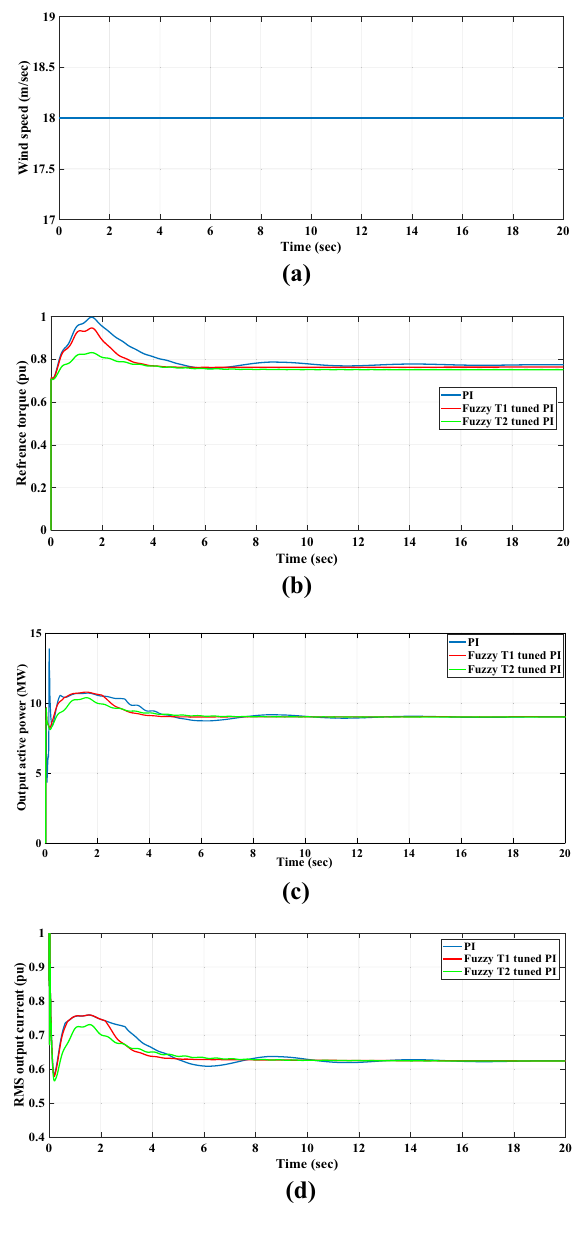
Fig. 12 Constant speed a wind speed, b reference torque, c output active power, d output